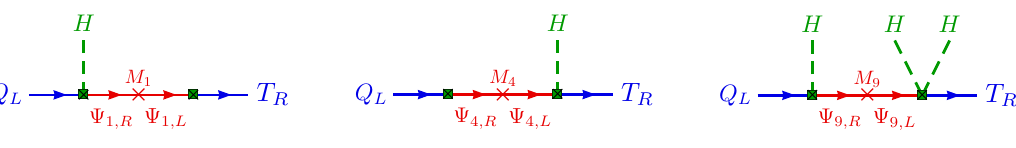
Figure 1 . Top-Higgs Yukawa coupling through mixing with singlet, 4-plet and nonet resonances (the mixing is represented by the green squares). The first two cases lead to a SM-like coupling to the Higgs (for H (cid:28) f ), while the nonet exchange leads to a cubic, non-renormalizable coupling ˜ Ht † H , at leading order in H/f q R H L